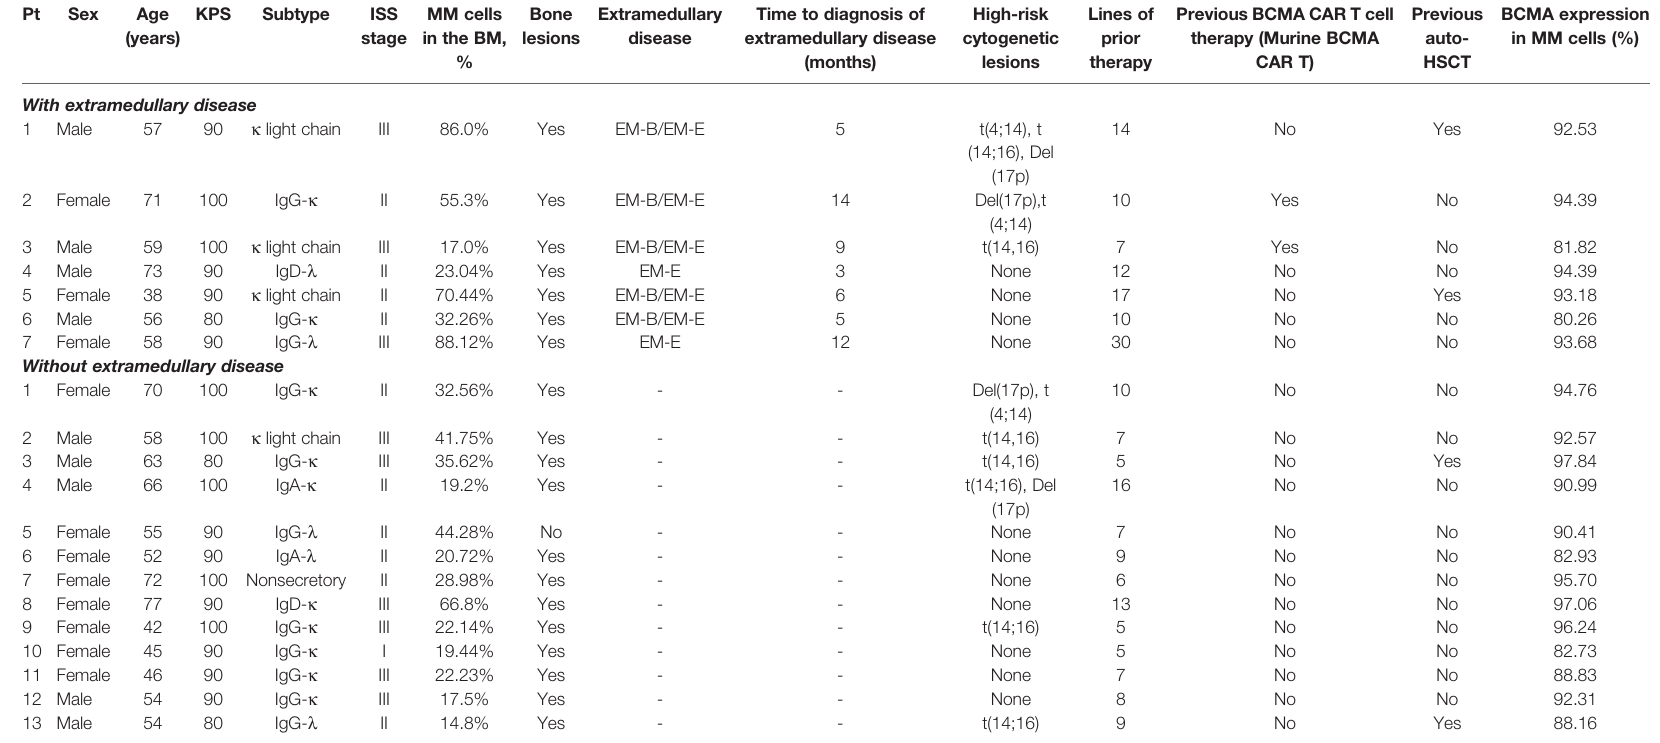
TABLE 1 | Baseline characteristics of the R/R multiple myeloma patients with or without extramedullary